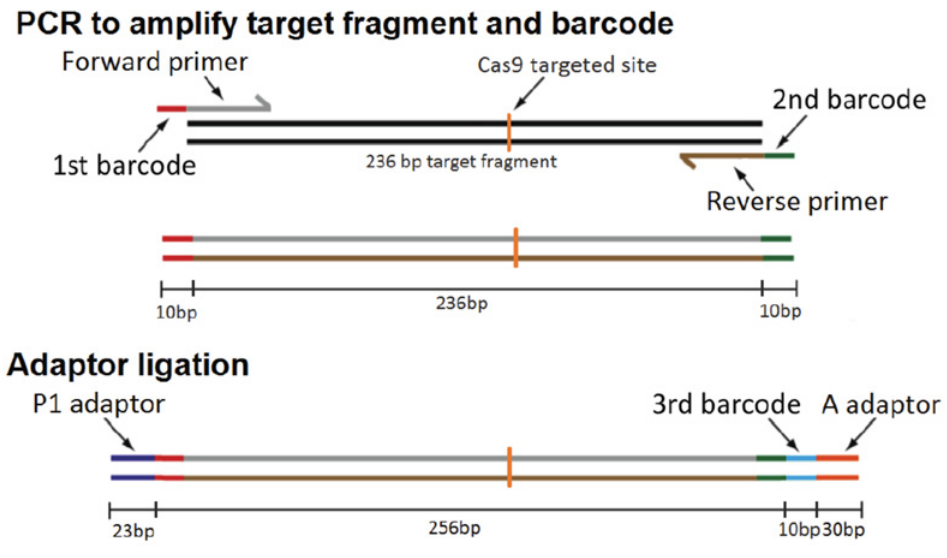
Figure 2. Preparation of NGS samples. Table 1. Base deletion/insertion in biallelic AC7 knockout (KO) BV-2